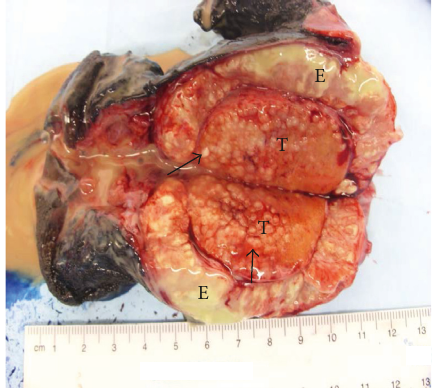
Figure 1: Axial computed tomography (CT) image, depicting a heterogeneous right testicle, with associated right scrotal fluid collection (long arrow) and inflamed right epididymis (short arrow).